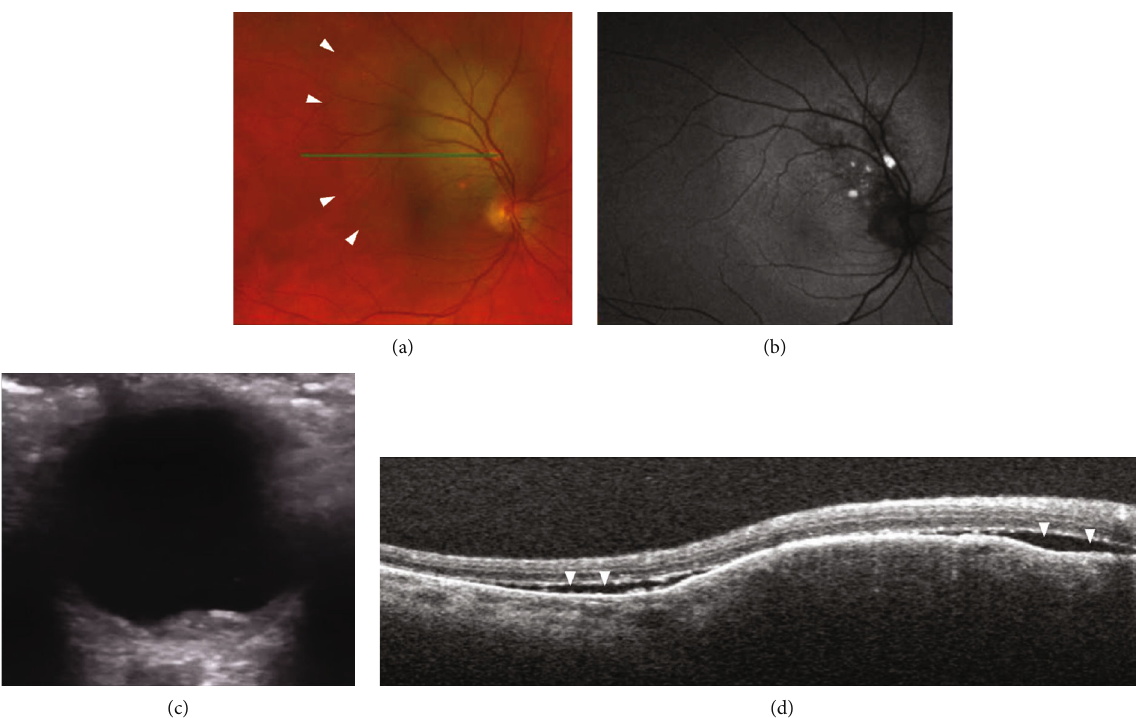
Figure 1: Right eye at presentation. (a) Fundus photograph showing choroidal mass and subretinal fl uid (arrowheads) with (b) corresponding auto fl uorescence image; (c) B-scan and (d) optical coherence tomography demonstrate exudative retinal detachment